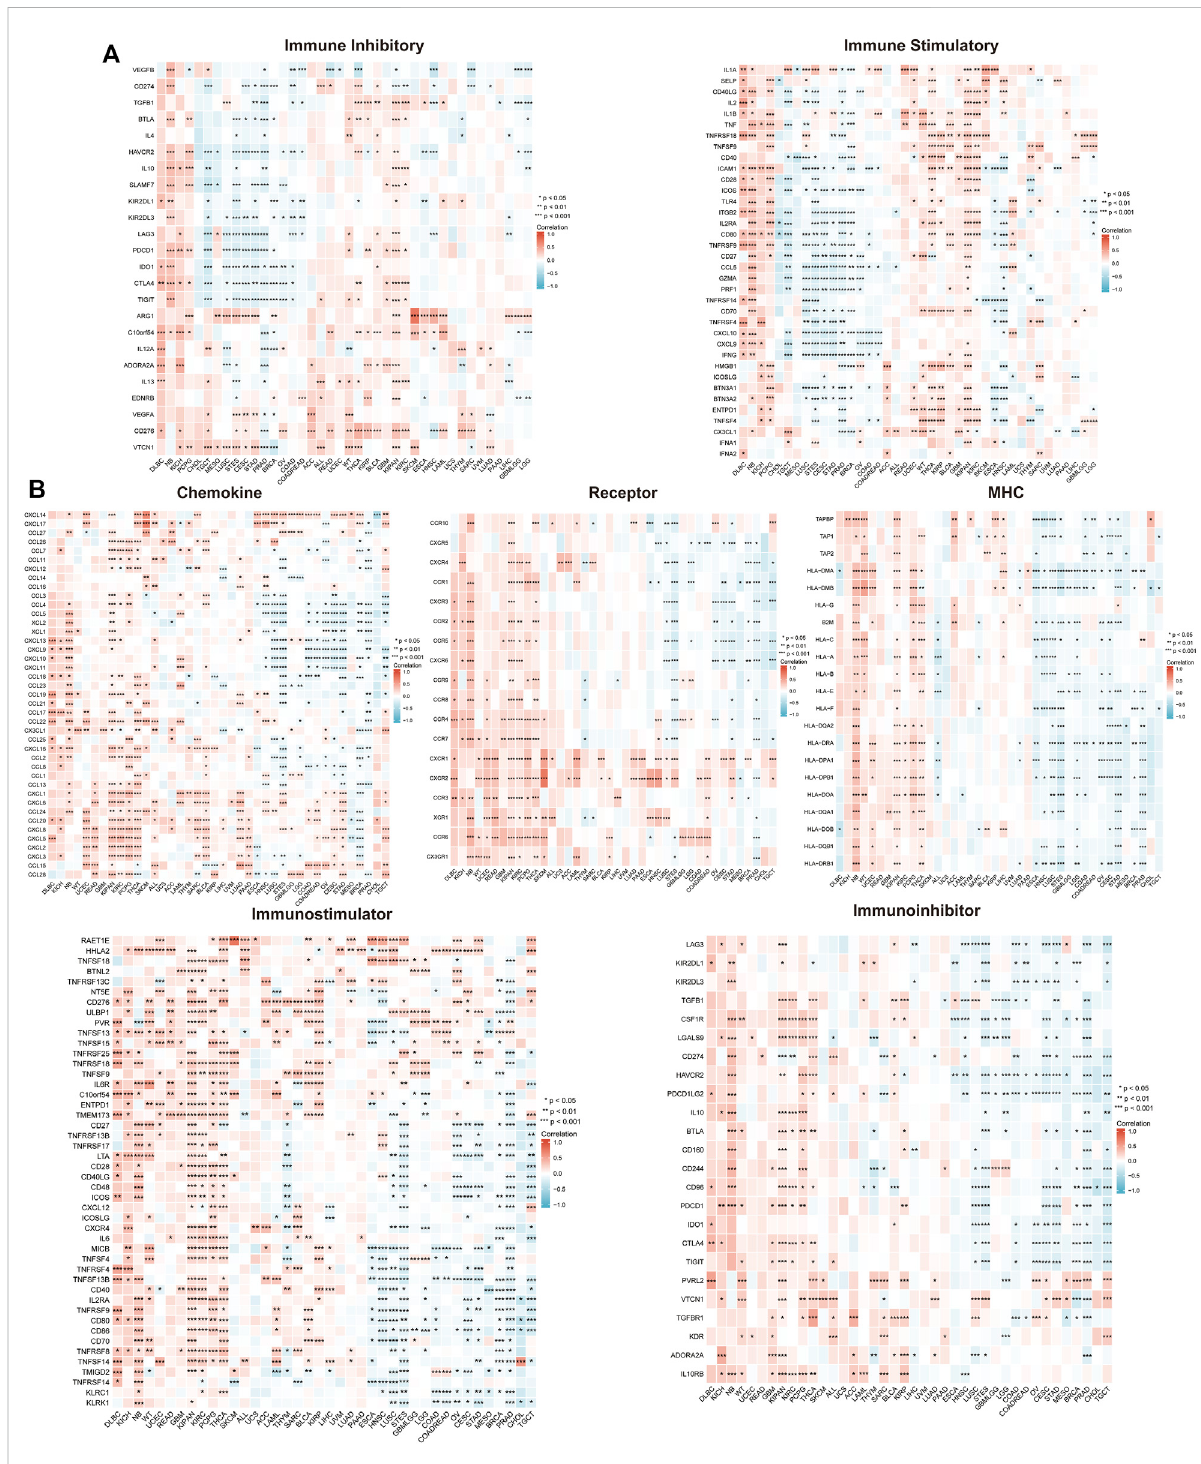
FIGURE 5 Correlation of TGM3 mRNA expression levels with immune checkpoint (A) and immune regulator (B) mRNA expression in pan-cancer from TCGA database. * p < 0.05, ** p < 0.01 and *** p <